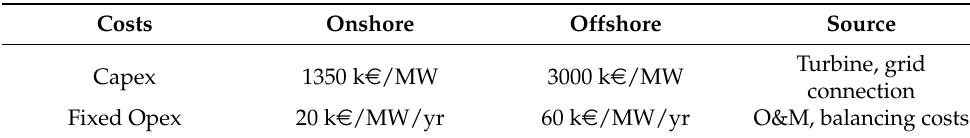
Table A3. Costs of onshore and offshore wind farms